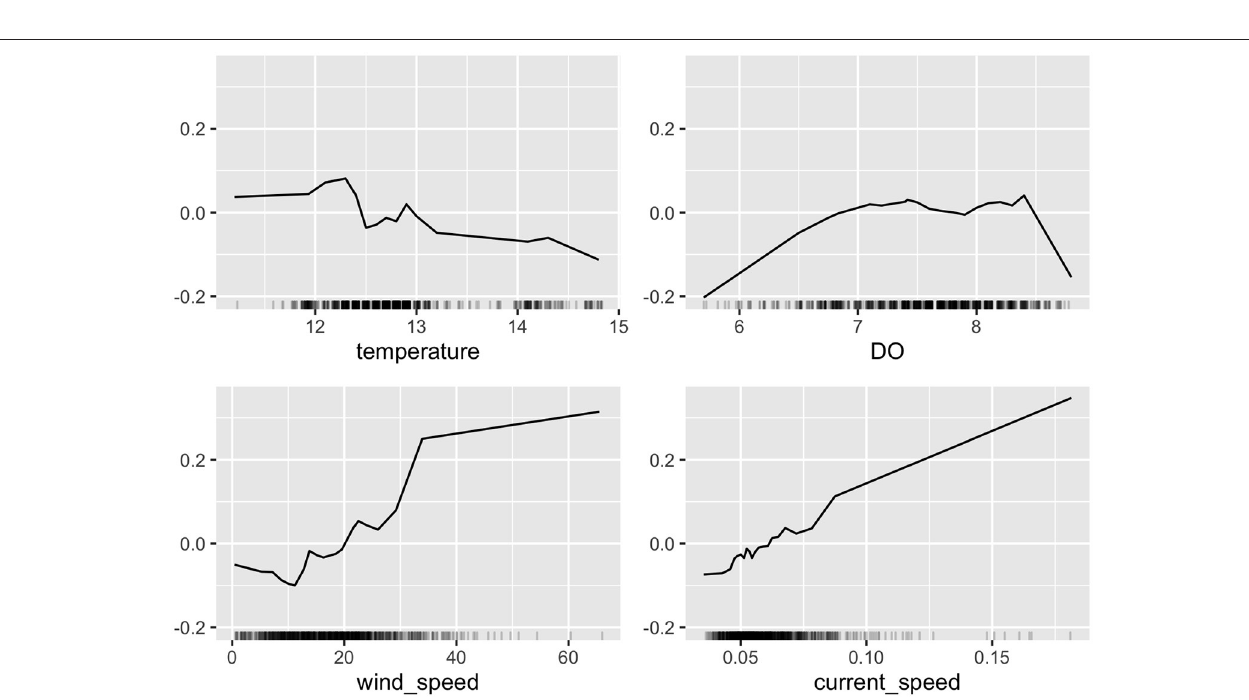
FIGURE 11 | Transect of temperature (left) and salinity (right) extracted from the Norkyst ocean model at the grid cell closest to the NOR farm. Colorbar denotes temperature in ◦ C and salinity in units of PPU for the respective plots.